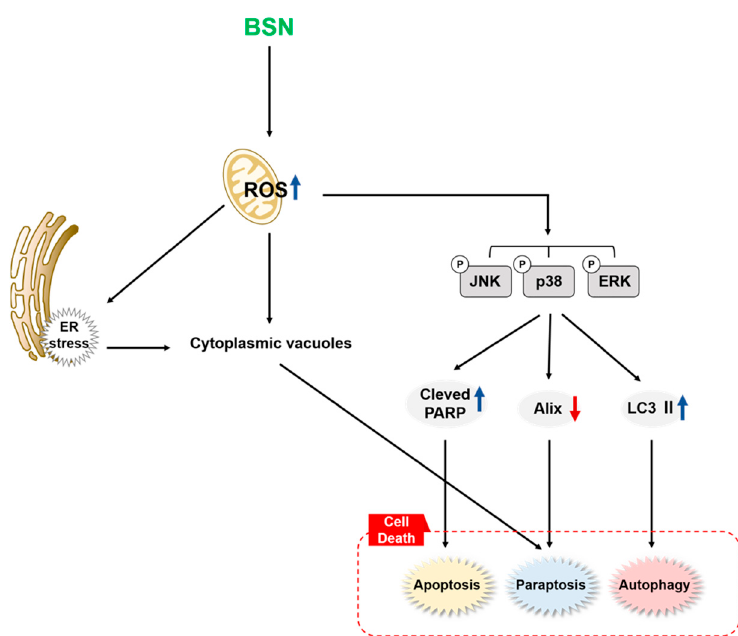
Figure 5. A schematic diagram showing mode of action of BSN.